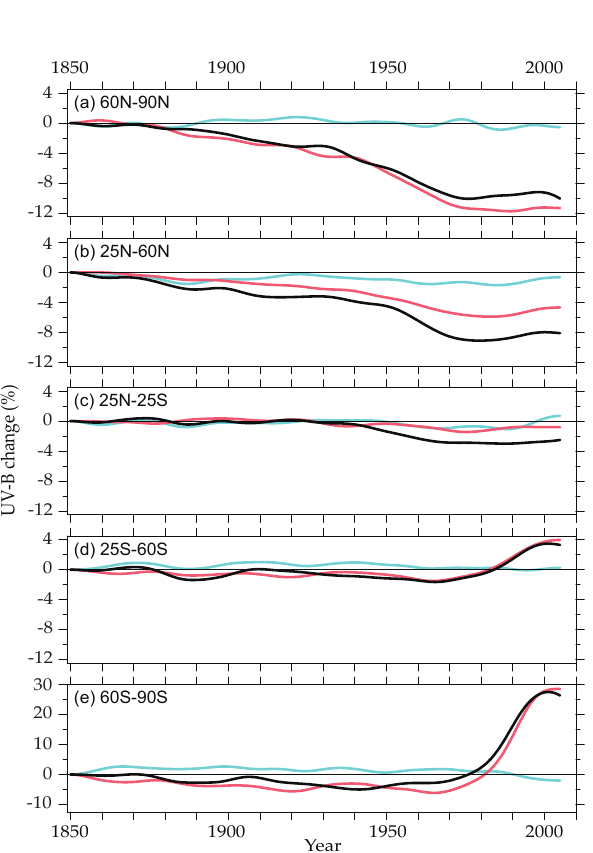
Fig. 1. Long-term evolution of the annual mean surface all-sky UV- B radiation simulated by MIROC-ESM-CHEM. Relative change to the 1850–1859 average is shown. Black curves show the results of the HIST simulation with full historical forcing, while the blue and red curves show the results with natural-only (NATo) and GHGs- only (GHGo) forcing, respectively. In order to focus on the long- term tendency in UV-B, the original time series were smoothed with a 1-2-1 filter applied 60 times. Note that the range of vertical axis in (e) is different from